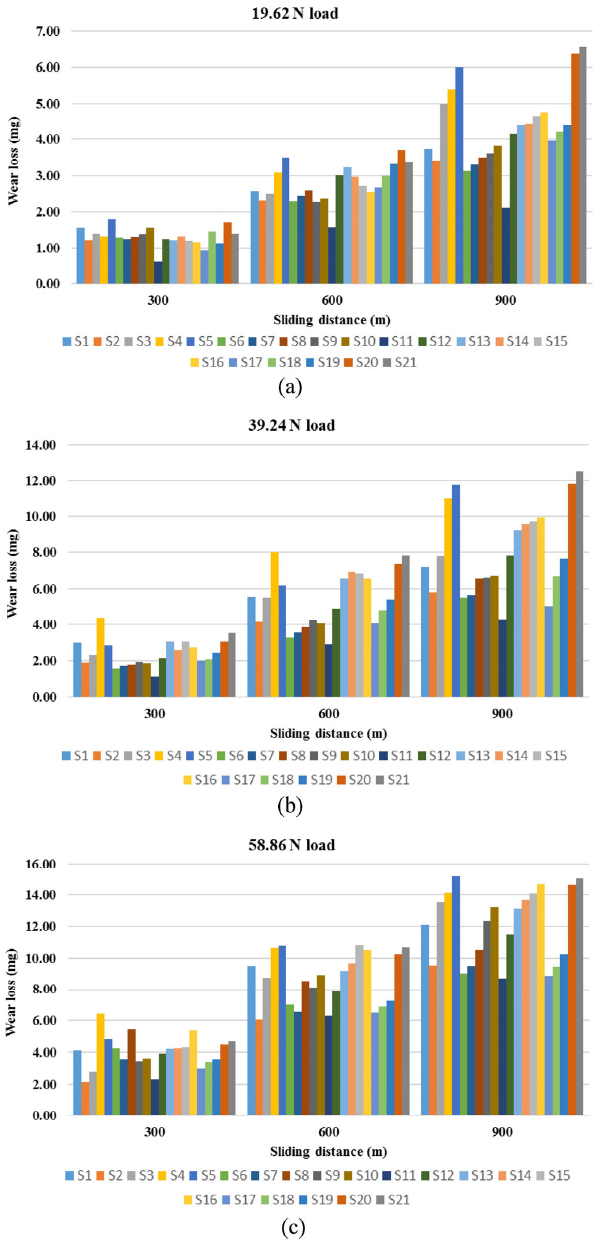
Fig. 5 Wear loss quantities at different normal